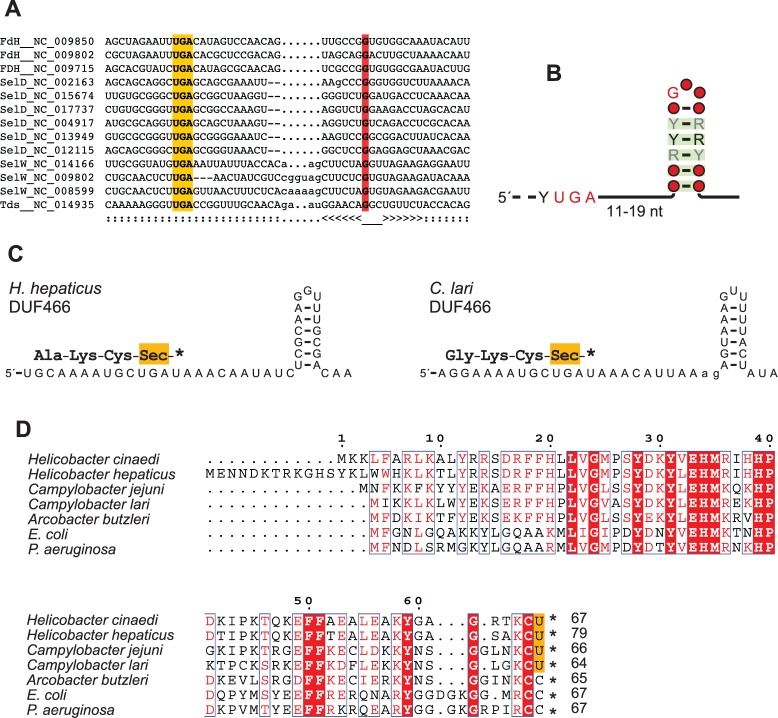
SECIS elements and identification of novel selenoproteins in ε-proteobacteria. (A) Nucleotide alignment of the region around the Sec codon in RNAs encoding known selenoproteins in ε-proteobacteria. The proposed base pairing is represented below the alignment in Stockholm notation; the TGA Sec codon is shaded in orange; the invariant guanosine in the hairpin loop is shaded in red. (B) Depiction of the consensus structure of SECIS elements in the full set of ε-proteobacterial selenoproteins; color code from covariance analysis is as in figure 1. (C) Proposed secondary structure of the identified SECIS elements of the H. hepaticus and C. lari DUF466 proteins. Protein translation is shown above the RNA sequence. (D) Multiple alignments of the DUF466 protein family in various bacteria. Residues conserved in all sequences are shaded in red; the putative Sec residues are shaded in orange.